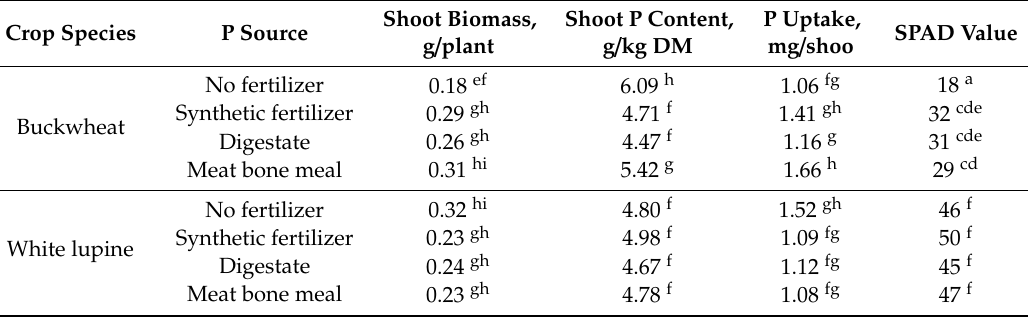
Table 1. Single plant shoot biomass (g / plant), phosphorus (P) content in shoots (g / kg DM), P uptake (mg / shoot), and soil-plant analysis development (SPAD) value of the studied crop species grown with di ff erent P sources. Data shown are means, n =